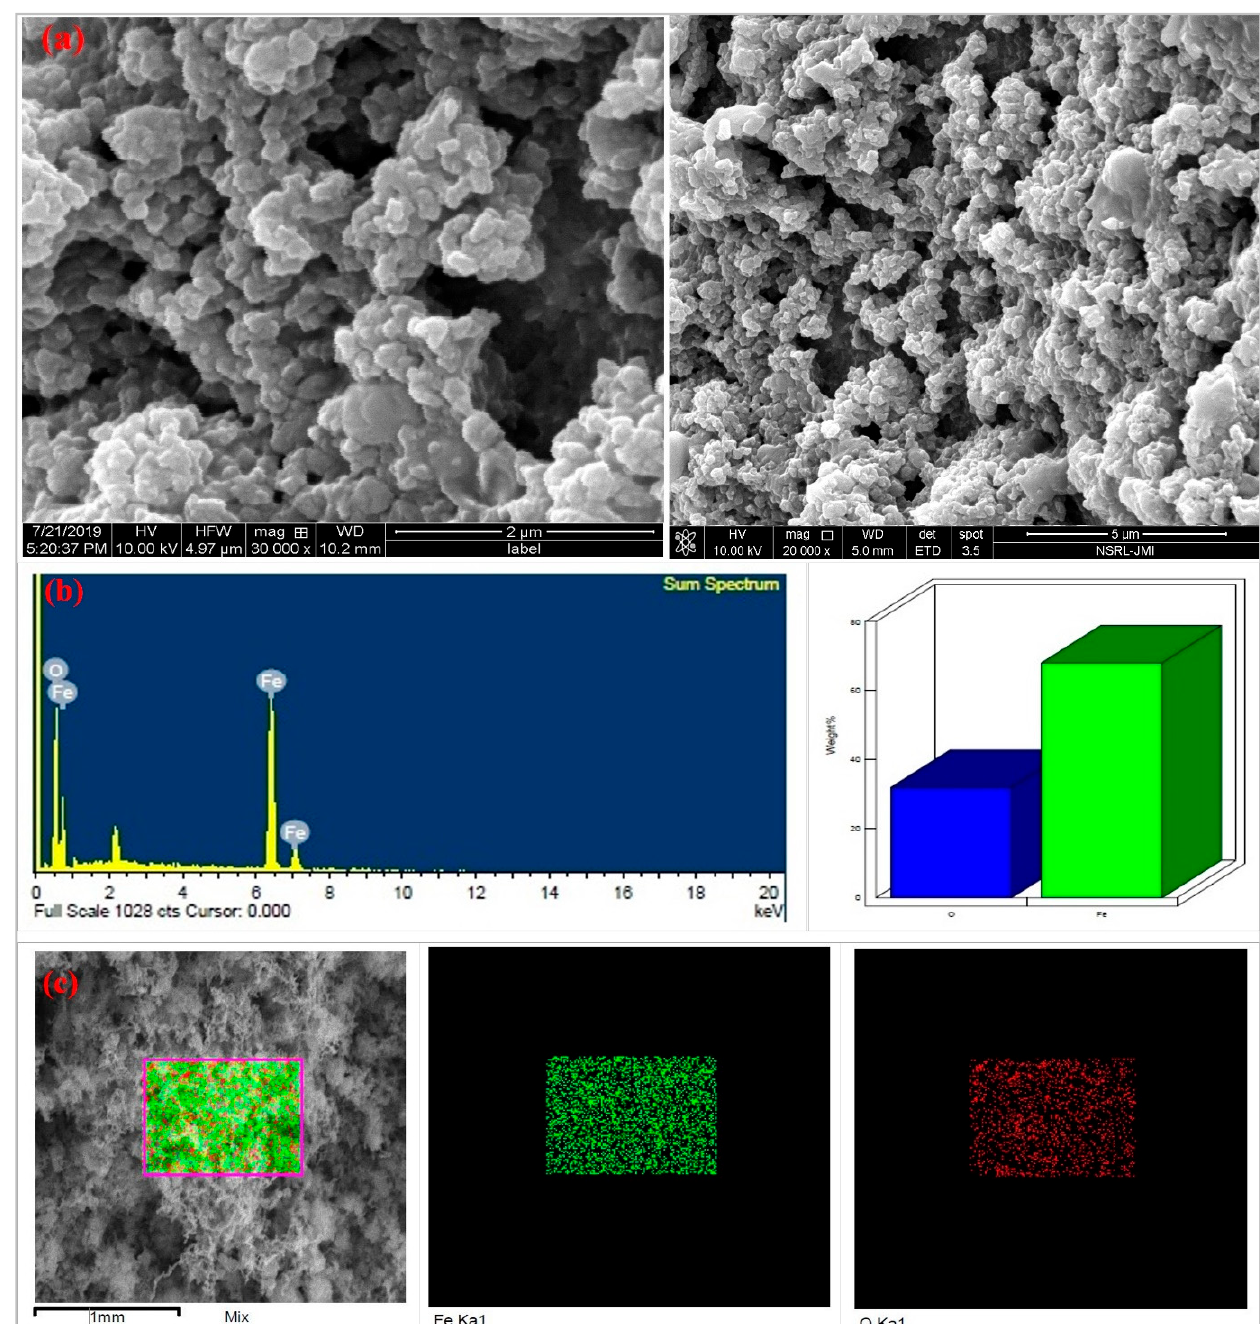
Figure 3. ( a ) SEM micrograph of nZVI at 2 µm and 5 µm. ( b ) EDX spectrum of synthesized nZVI and ( c ) elemental mappings.